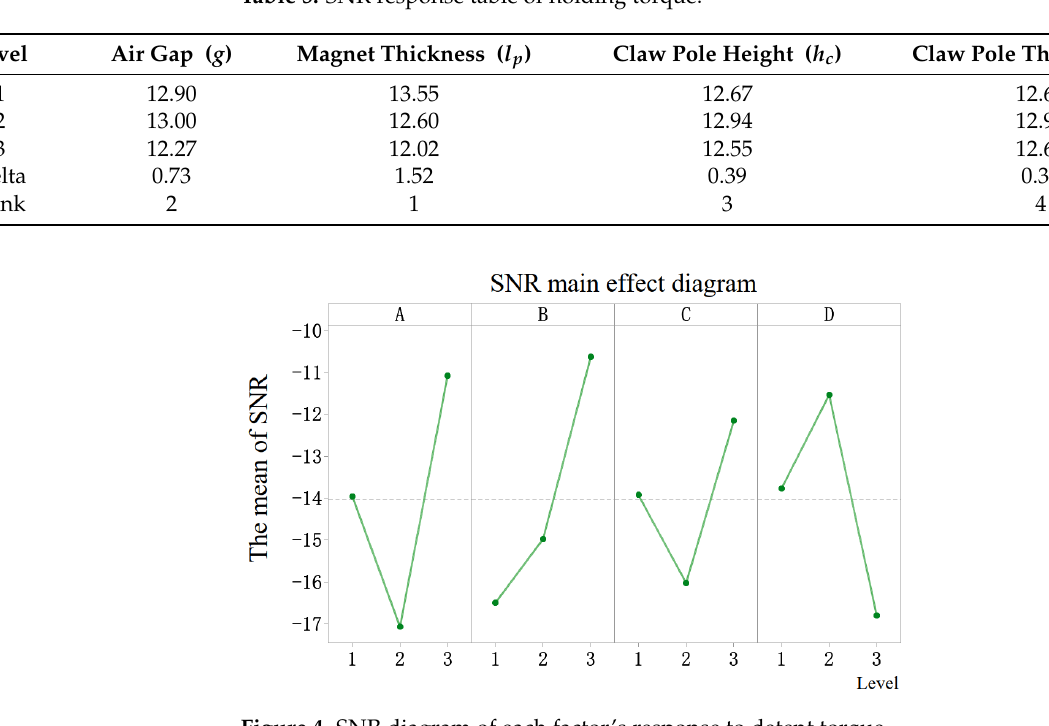
Table 5. SNR response table of holding torque.